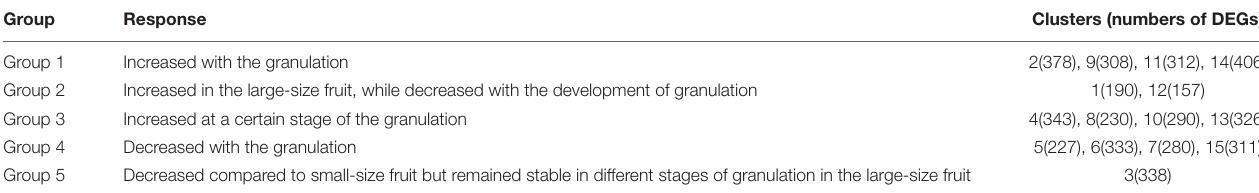
TABLE 1 | Granulation responsive category analysis of DEGs based on Mfuzz cluster